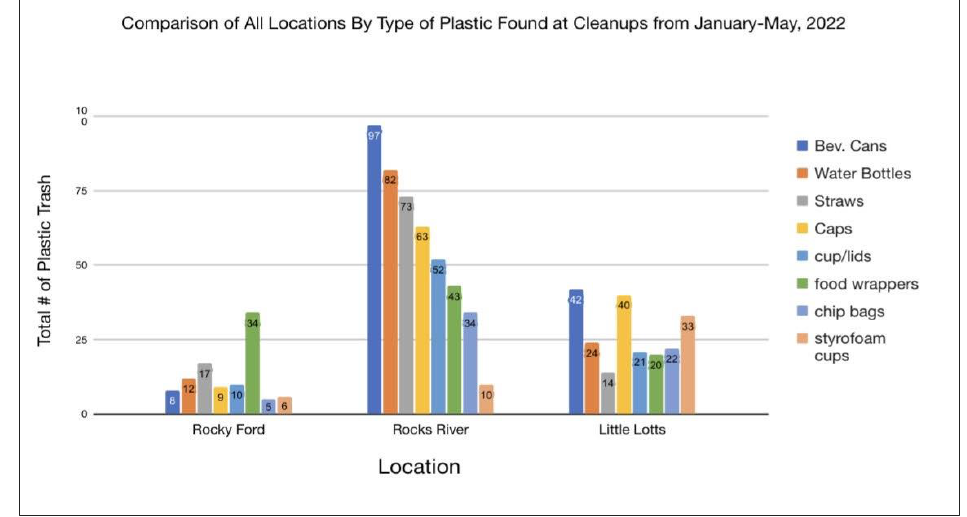
Figure 16. Trash Analysis — Plastic Products Found During